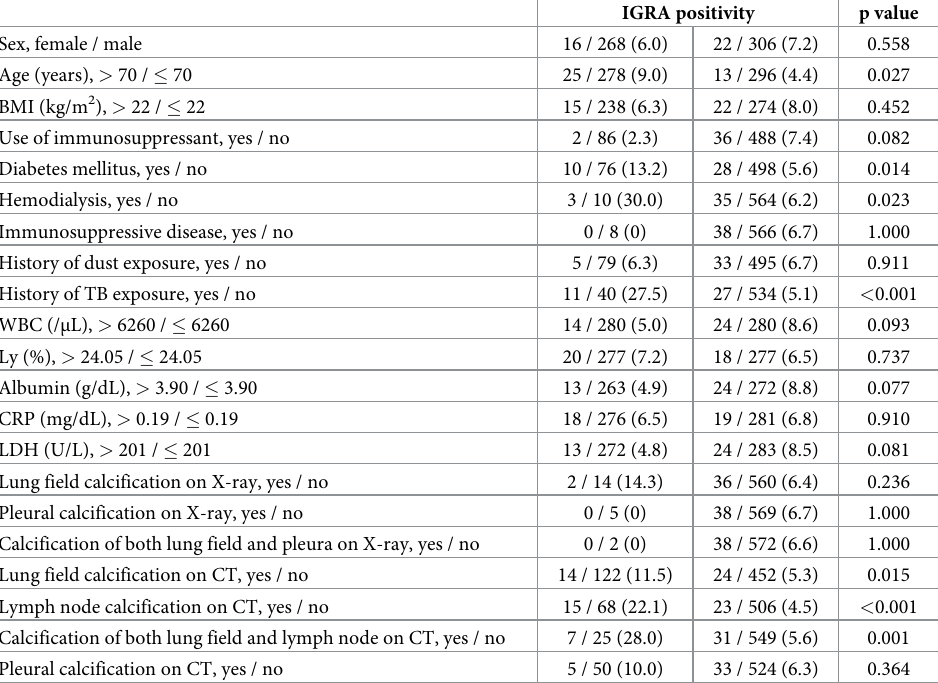
Table 1. IGRA positivity in the baseline characteristics and chest radiological features.